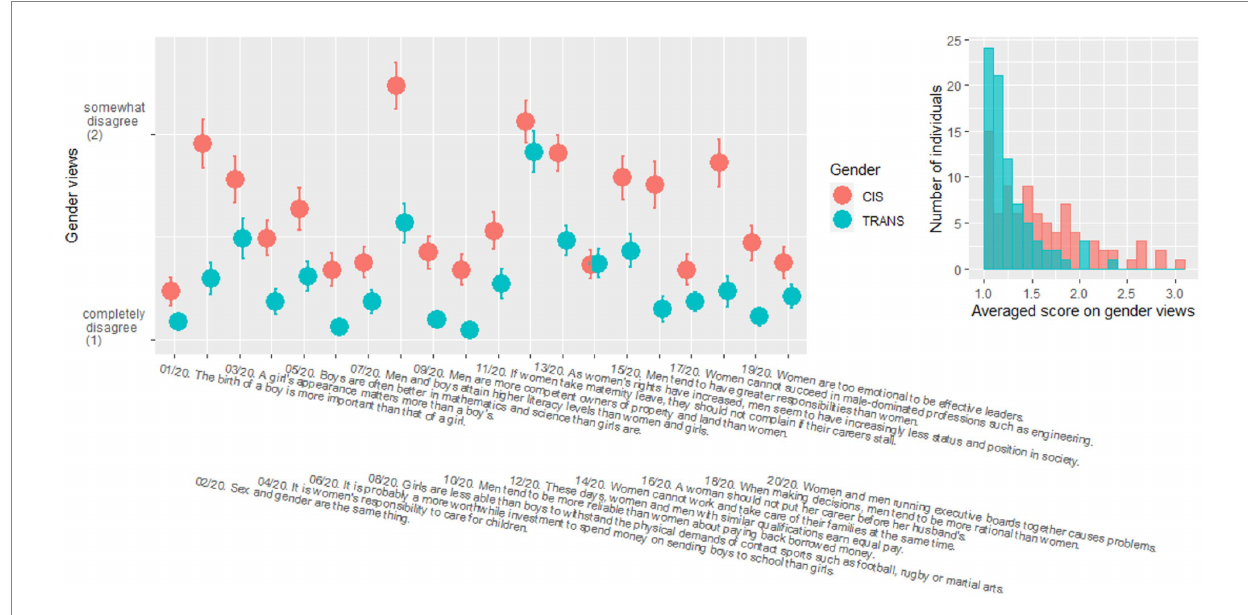
FIGURE 3 Scores obtained by cis (red) and trans (blue) participants in the questionnaire evaluating gender views, with means and standard errors in each population (left panel). Histogram of the averaged score across the 20 questions in each population (right panel). See Supplementary material 5 for a full list of the gender views questions.